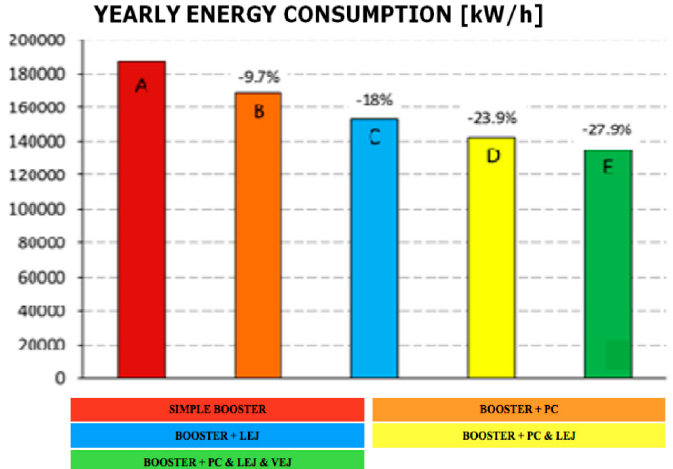
Figure 13. Energy savings of various transcritical R744 booster supermarket refrigeration systems compared to a conventional transcritical R744 booster supermarket refrigeration plant in Southern Italy [47].